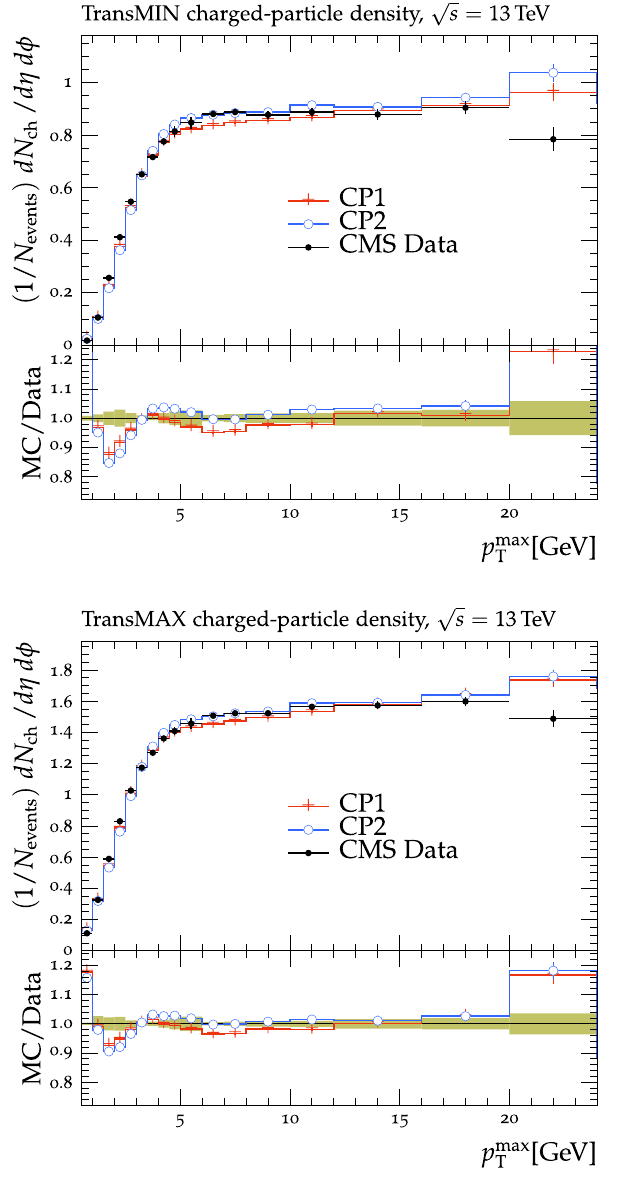
Fig. 4 The transMIN (upper left) charged-particle and charged p sum ISR and FSR. The data are compared with the CMS pythia 8 LO-PDF T (upper right) densities and the transMAX (lower left) charged-particle tunes CP1 and CP2. The ratios of the simulations to the data (MC/Data) and charged p sum are also shown, where the shaded band indicates the total experimental (lower right) densities, as a function of the trans- T uncertainty in the data. Vertical lines drawn on the data points refer to verse momentum of the leading charged particle, p max , from the CMS √ T s = 13TeV analysis [16]. Charged hadrons are measured with the total uncertainty in the data. Vertical lines drawn on the MC points p T > 0 . 5GeV in | η | < 2 . 0. The transMIN densities are more sen- refer to the statistical uncertainty in the predictions. Horizontal bars indicate the associated bin width sitive to the MPI, whereas the transMAX densities are more sensitive to